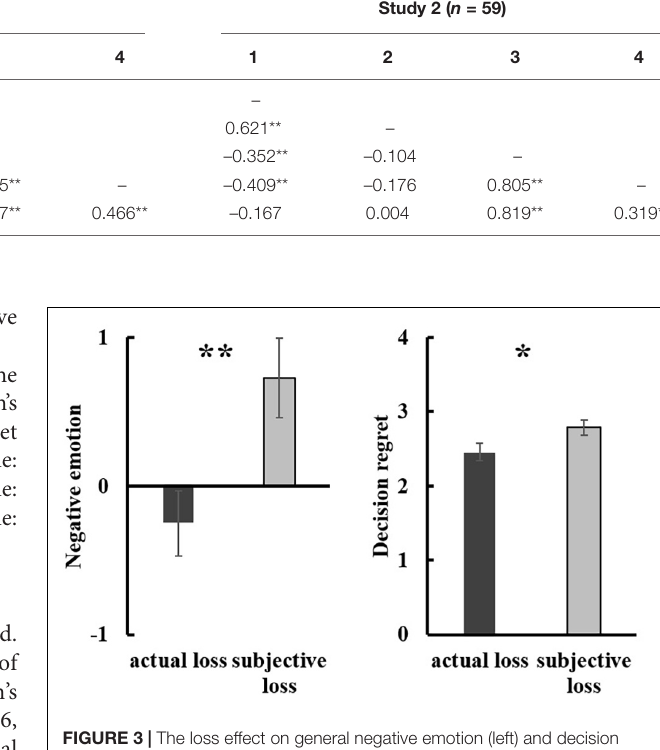
FIGURE 3 | The loss effect on general negative emotion (left) and decision regret (right) in Study 2. Error bars represent standard errors. *p < 0.05; **p < 0.01.